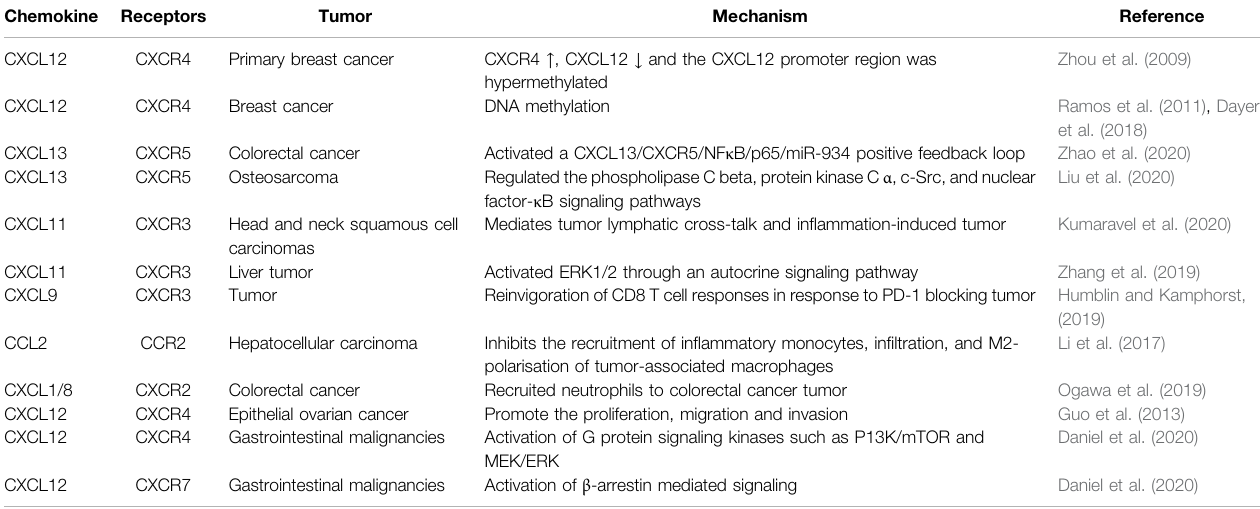
TABLE 2 | Effects on chemokines and their receptors in cancer. Chemokine